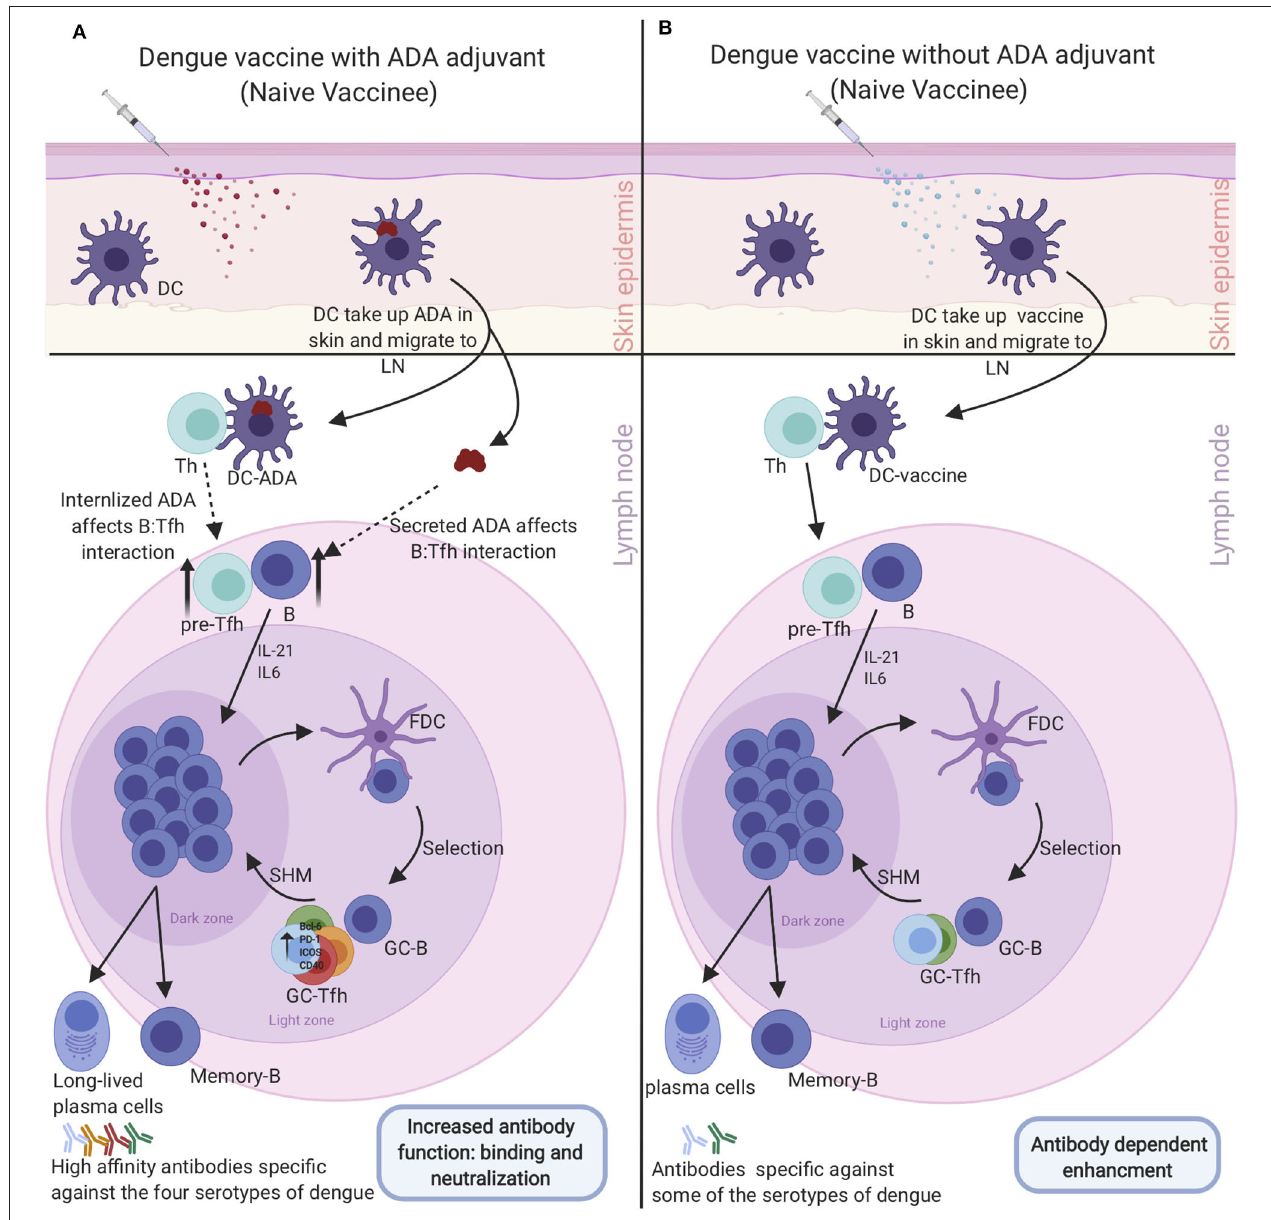
FIGURE 5 | Enhancement of dengue vaccine by targeting Tfh cells to overcome dengue serostatus effect: (A) Administering dengue vaccine to naive dengue individual with Tfh Adjuvant (ADA) will be taken up by DC that travels to the LN and prompt enhanced Tfh-B cell interaction. The enhanced interaction induces Tfh-specific cells to the four dengue serotypes leading to differentiation of memory B cells and plasmablasts that produce high-affinity neutralizing antibodies against all the serotypes which neutralize the dengue virus. (B) Administrating dengue vaccine to naive individuals without Tfh adjuvant (ADA). Vaccine will be taken up by DC, which will travel to the LN and induce medium Tfh-B cell interaction. The medium interaction will give rise to Tfh, B cells, and plasmablasts that are specific to some serotypes of dengue. Antibodies produced by this response will make them vulnerable to ADE and enhanced dengue diseases upon infection with a different dengue serotype virus that they have sub-neutralizing antibodies